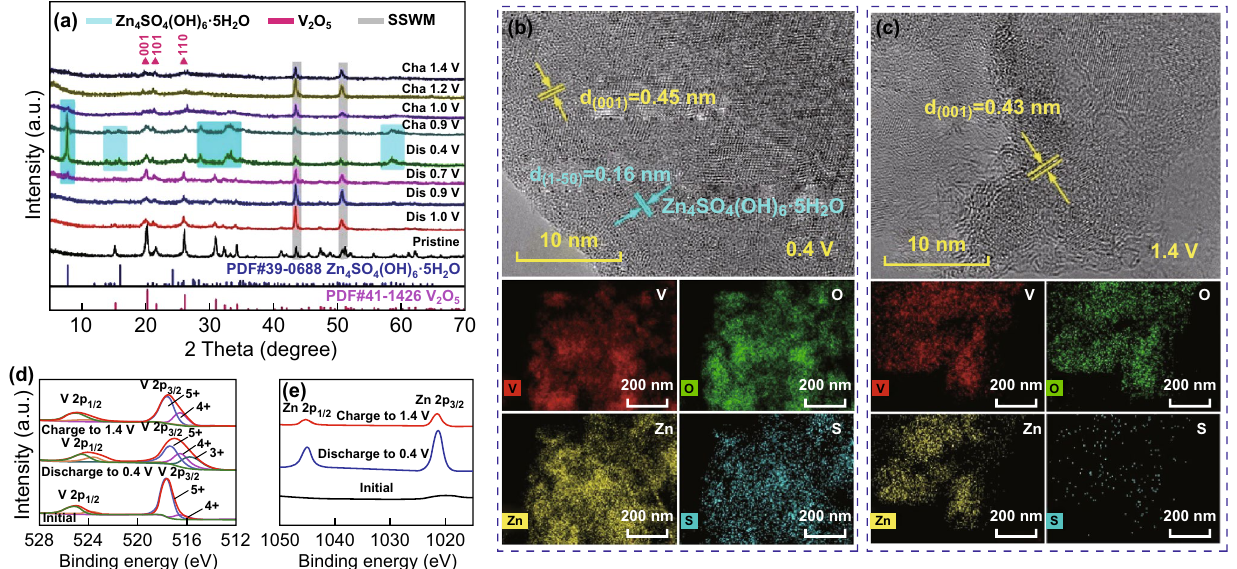
Fig. 5 Analysis of the Zn storage mechanism of the V 4+ -V 2 O 5 electrode. a Ex situ XRD patterns of V 4+ -V 2 O 5 electrodes discharged or charged to different voltage states at the current density of 100 mAg −1 , HRTEM, and TEM-EDS mapping images of the electrodes b discharged to 0.4 V and c charged to 1.4 V, ex situ high-resolution XPS spectra of d V 2p and e Zn 2p at the fully discharged/charged